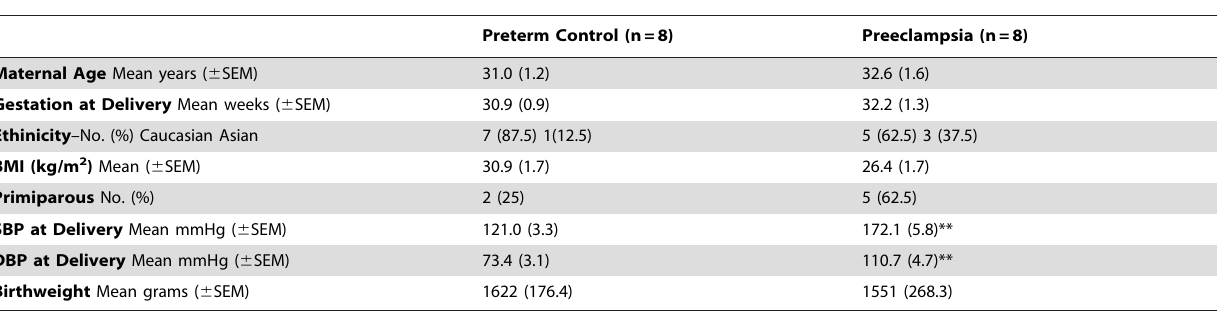
Table 1. Clinical Characteristics of the preeclamptic